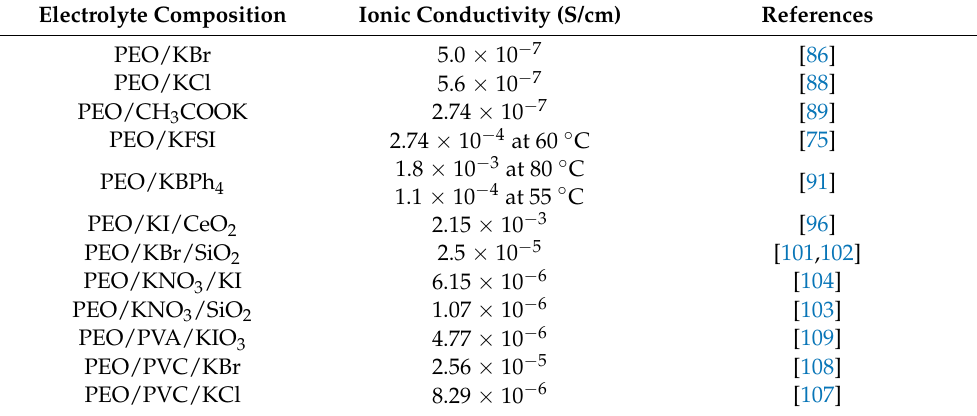
Table 2. Performance parameters of PEO-based Pes for KIBs. Electrolyte Composition Ionic Conductivity